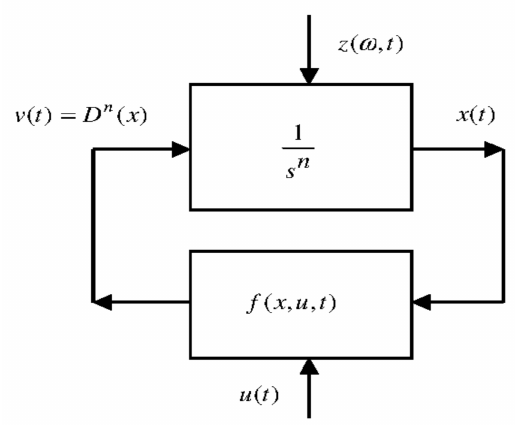
Figure 1. Modeling with a fractional